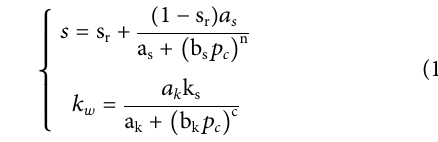
Frontiers in Earth Science |